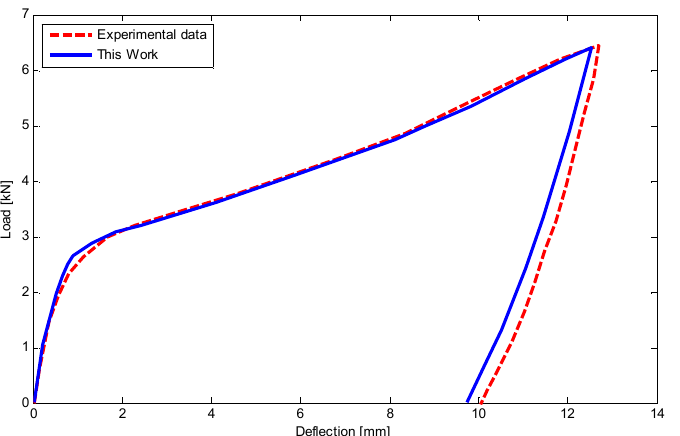
Figure 18. Comparison of different degrees of polynomial approximation function for deflection of SMA beam along the length. Example 3: four-point bending tests. According to ASTM E855 − 08, we have fi nally conducted two four-point bending tests under different applied load for circular beams. The test specimens have a length and diameter of 300 and 20 mm, respectively. The distance between loading and support- ing points are 130 and 200 mm (Figure 19). Two LVDTs (linear variable displacement transducer) are installed at the center and one end of the beam to measure the displace- ment. To assess the bending behavior of the SMA beam under bending before initiation of T- and D-zones favored by tension, applied loads in the first and second tests are, re- spectively, about 17 and 19 kN.